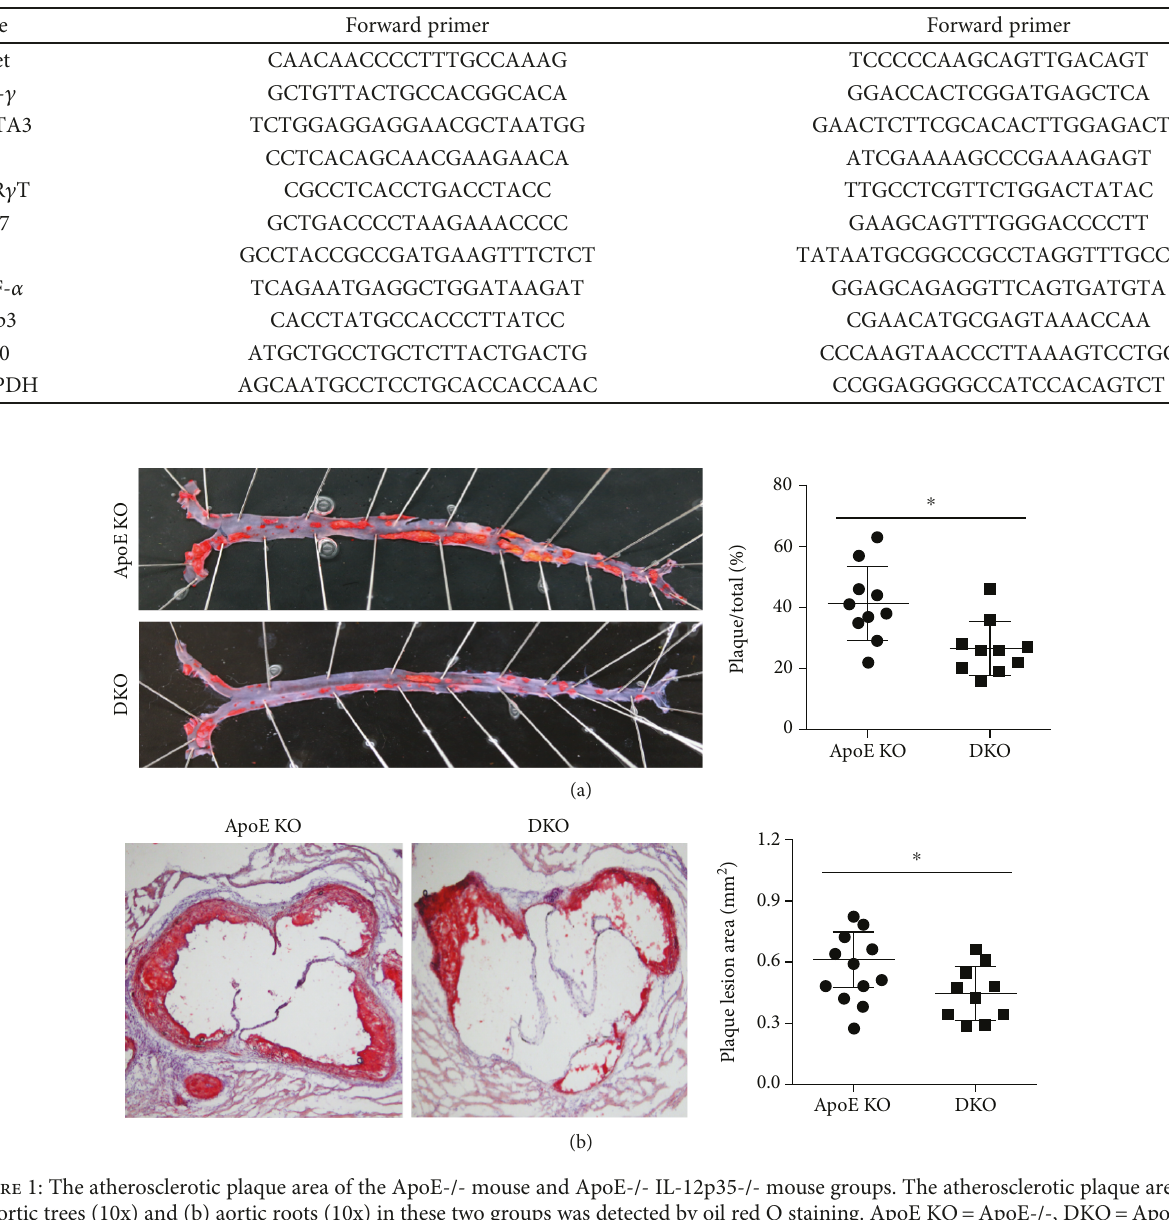
Table 1: RT-qPCR primers used.